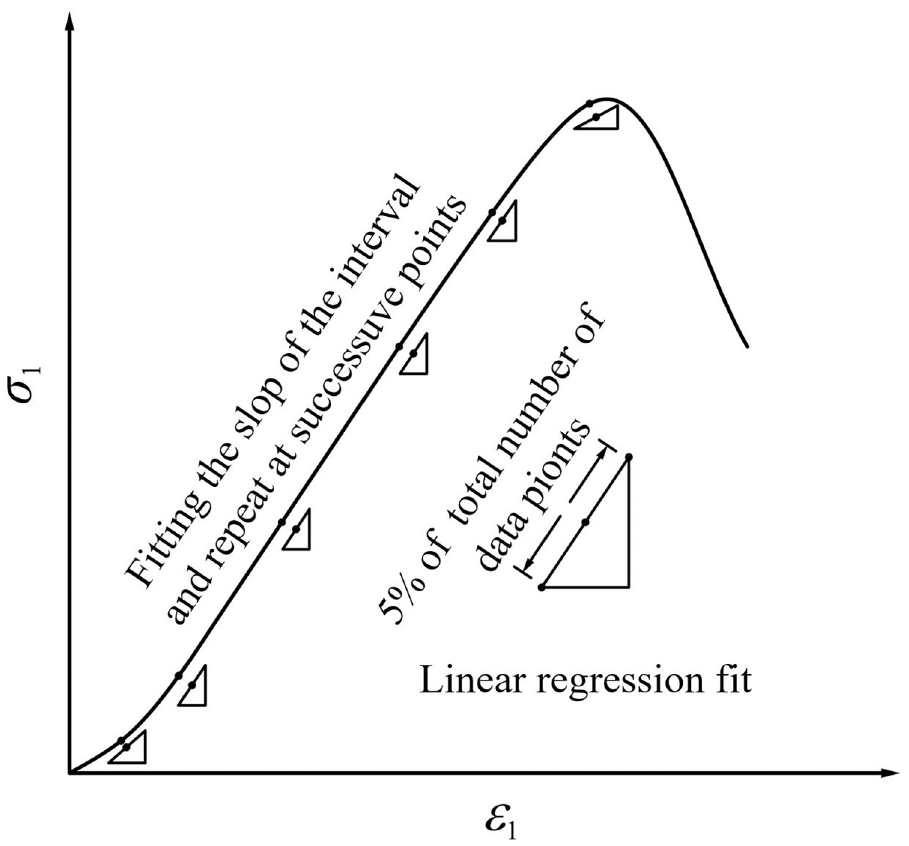
Fig 6. Moving point regression technique (after reference